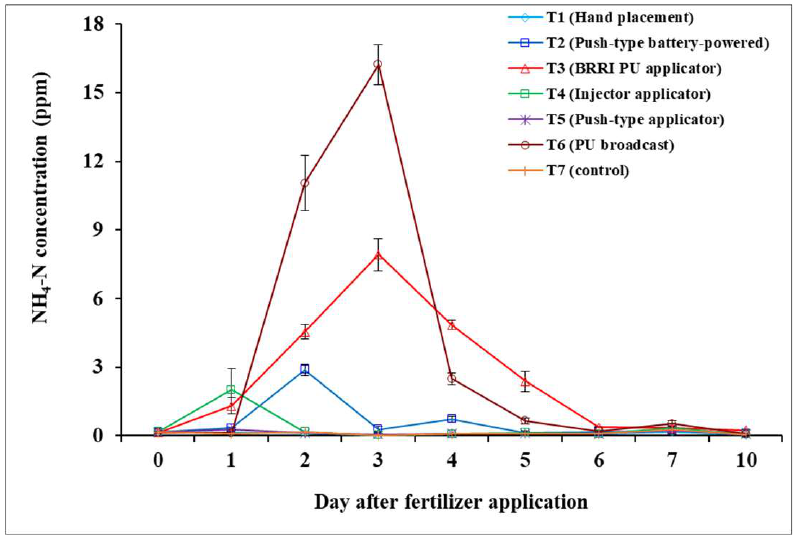
Figure 1. Trend of NH 4 + -N release in flood water under different methods of urea fertilizer application in T. Aman rice field at BAU Farm.